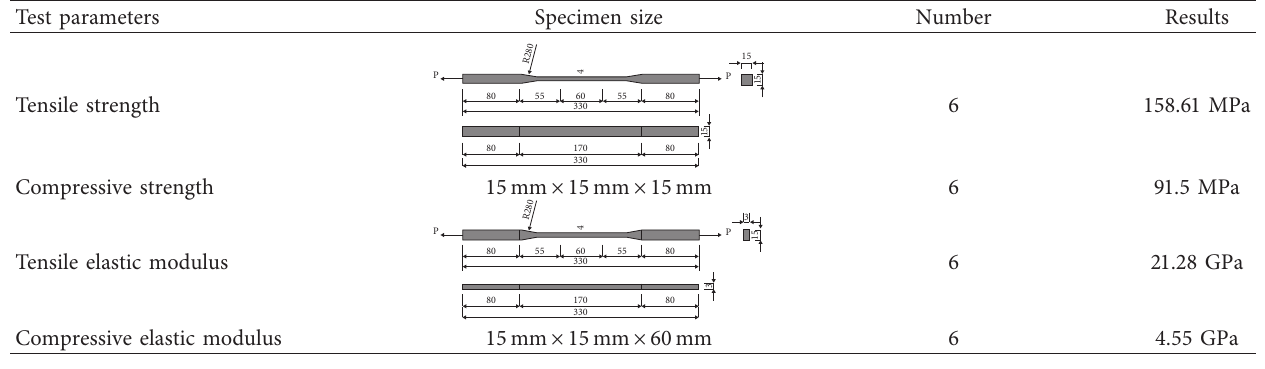
Table 2: Test details and results of bamboo scrimber.